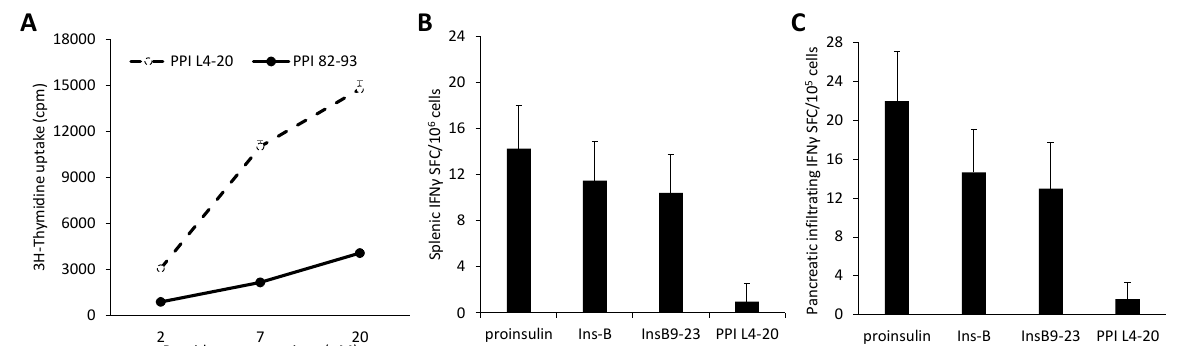
Figure 1. PPI L4-20 is an immunogenic preproinsulin determinant that is ignored by spontaneous autoimmune responses in NOD mice. ( A ) Lymph node T cell proliferation following immunization with PPL L4-20 and PPI 82-93 and challenge with each immunogen. To determine whether PPL L4-20 and PPI 82-93 contain immunogenic determinants of PPI, female NOD mice (6–8 weeks old) were immun- ized with PPL L4-20 and PPI 82-93 (50 µg of each in 50% CFA) in their food-pads. Nine days later, the mononuclear cells from the draining lymph nodes of individual mice were stimulated with PPI L4-20 (dashed line) or PPI 82-93 (solid line) at the indicated concentration for 72 h. The antigen-specific T cell proliferation was determined by 3 H-thymidine uptake. Data are expressed as the mean ± SD of each group ( N = 4) from two separate experiments. The control cells without antigen stimulation dis- played mean counts from 679 to 834 cpm (data not shown) while the positive group of cells that had been stimulated with anti-CD3 (1 µg/mL) or PPD (5µg/mL) displayed means of 23,540 or 18,760 cpm, respectively. ( B , C ) ELISPOT analysis of the numbers of spontaneously arising ( B ) splenic and ( C ) pancreatic infiltrating IFN γ -secreting T cell responses to ß-cell antigens. Splenic mononuclear cells or a mixture of pancreatic lymph node and islet-infiltrating mononuclear cells that were iso- lated from 12–13 weeks old unmanipulated female NOD mice were tested for their IFN γ responses to proinsulin, insulin B chain, insulin B 9-23 , and PPL L4-20 by ELISPOT assays. The data are expressed as the mean ± SD of spot forming cells (SFC) in 10 6 splenocytes, or 10 5 pancreatic infiltrates in each group ( n = 6) from two separate experiments. The number of SFC in the control was ≤ 3 and the number of SFC from anti-CD3 stimulated cells was about 220.